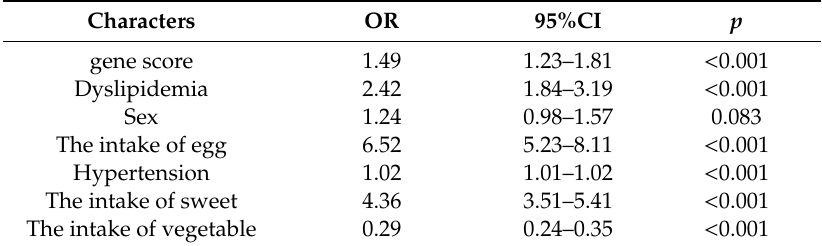
Table 3. Associations of gene score and lifestyles with risk of